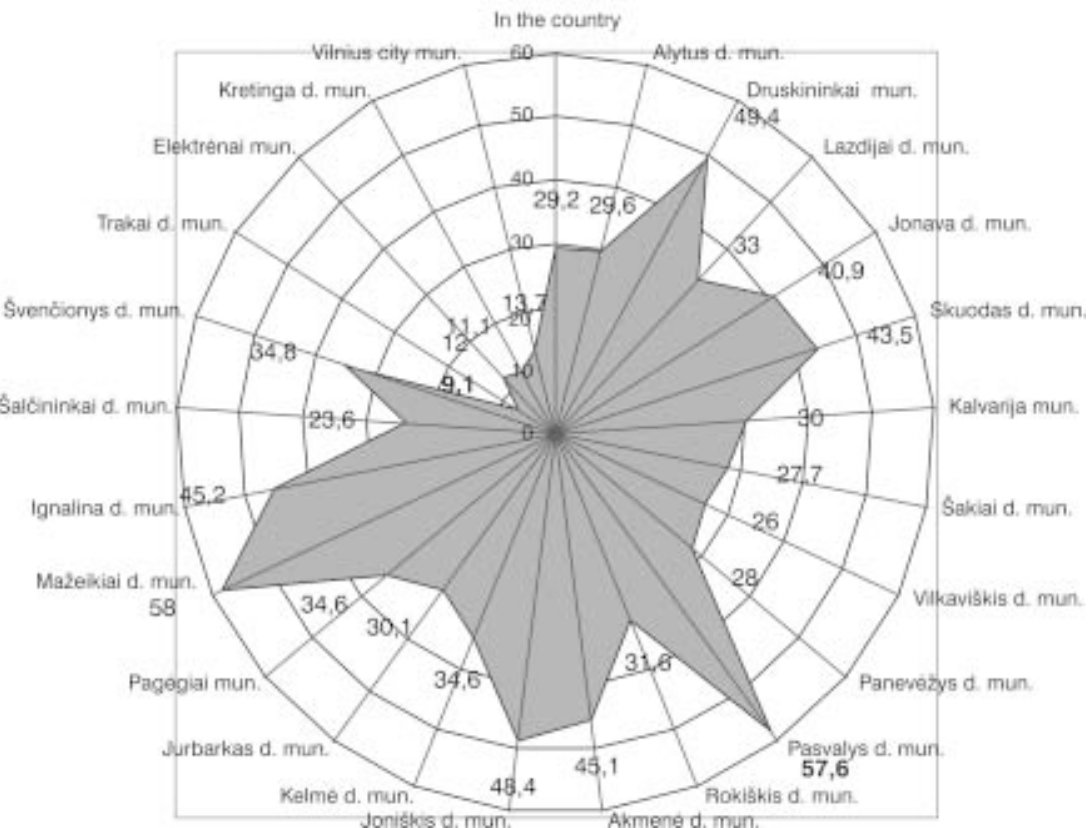
Fig 3. Portion of long-term unemployed individuals in the municipalities of depressive regions of Lithuania in 2004